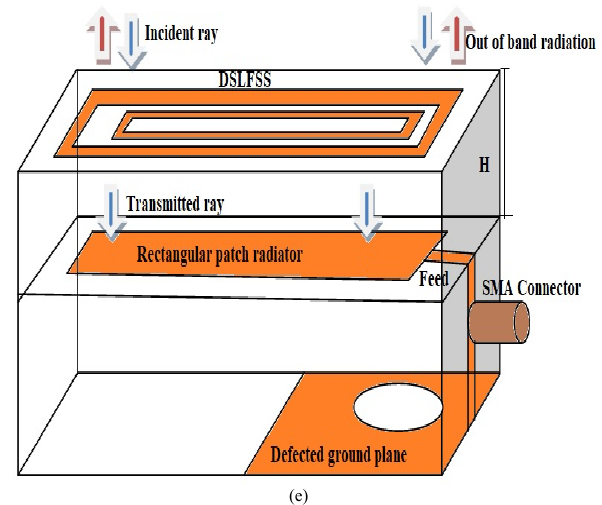
FIGURE 5: Configuration of the DSLFSS based PAR (a) full ground, (b) half ground, (c) partial slotted ground, (d) front view of patch antenna radiator, and (e) schematic diagram of the stacked antenna.